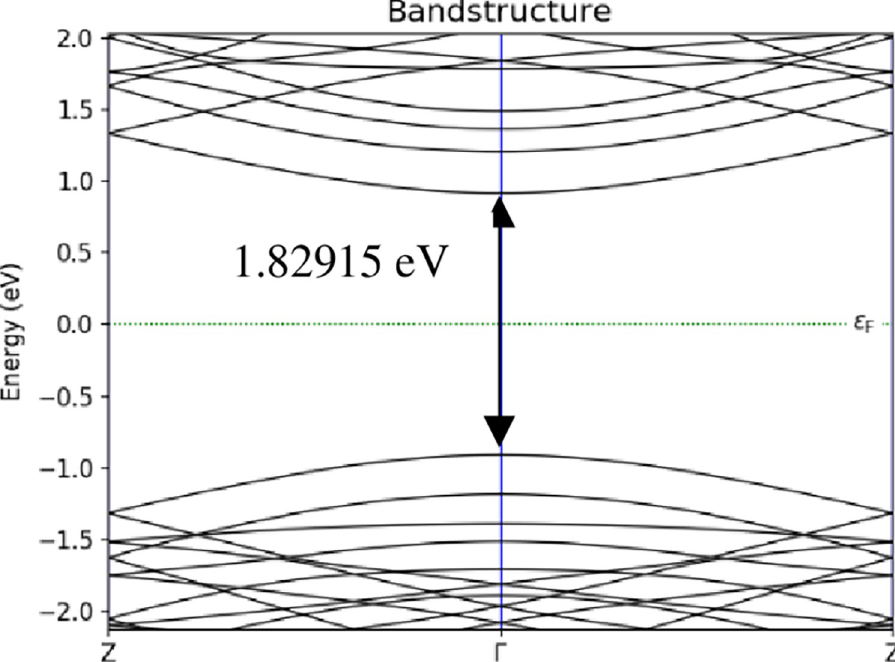
Fig 8. Energy band structures of 12-BC 2 NNR with different positions of H 2 gas molecules at carbon atom for T = 298 K .